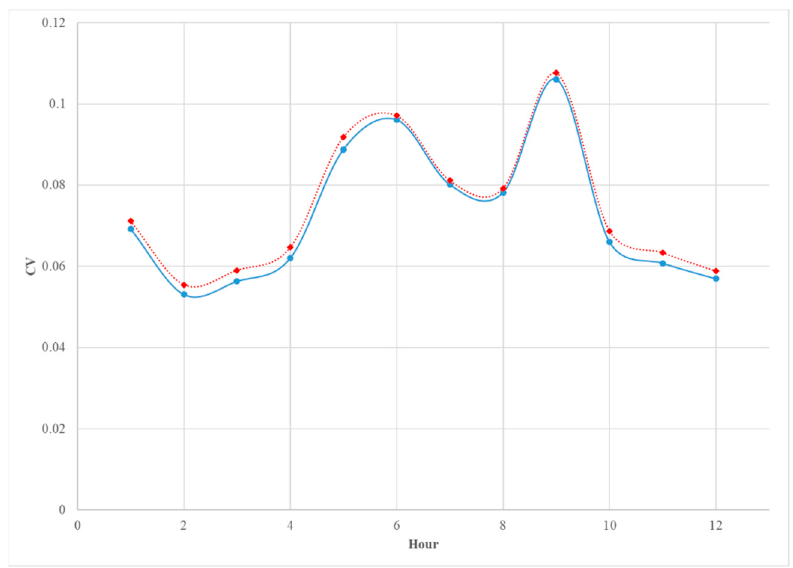
Figure 9. The comparison between the CV of the predicted monthly average load of Model 1 (blue solid) and Model 2 (red doted). Energies 2019 , 12 , x FOR PEER REVIEW